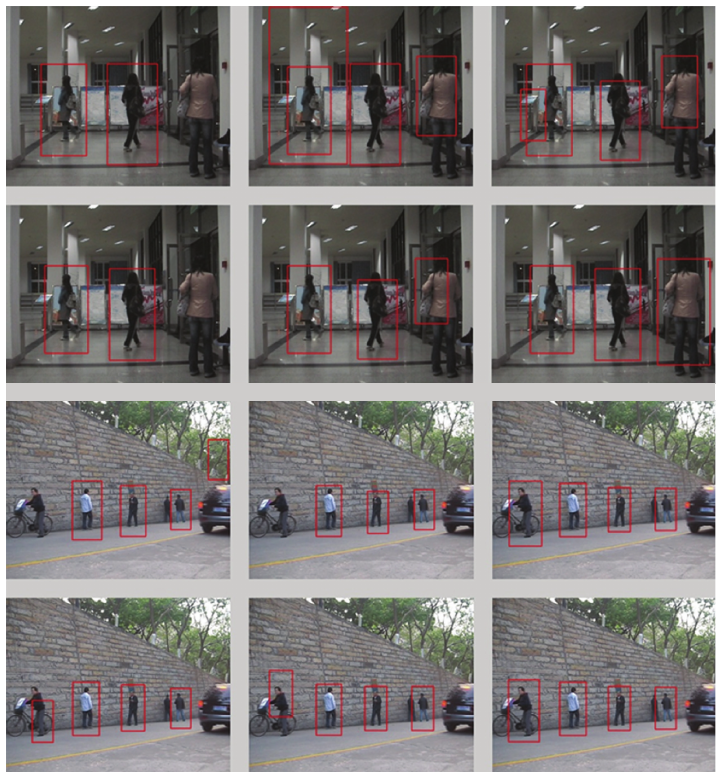
Figure 9: Detection results on XMU-VIS. From left to right and top to down, the classifiers are HOG lin, LBP lin, HOG LBP lin, HOG HIK, LBP HIK, and HOG LBP HIK.